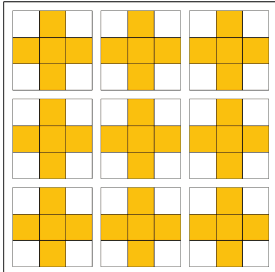
Figure 13. A sample integral image of dimensions 9 × 9. The shaded regions indicate the integral image values that need to be stored in the memory.